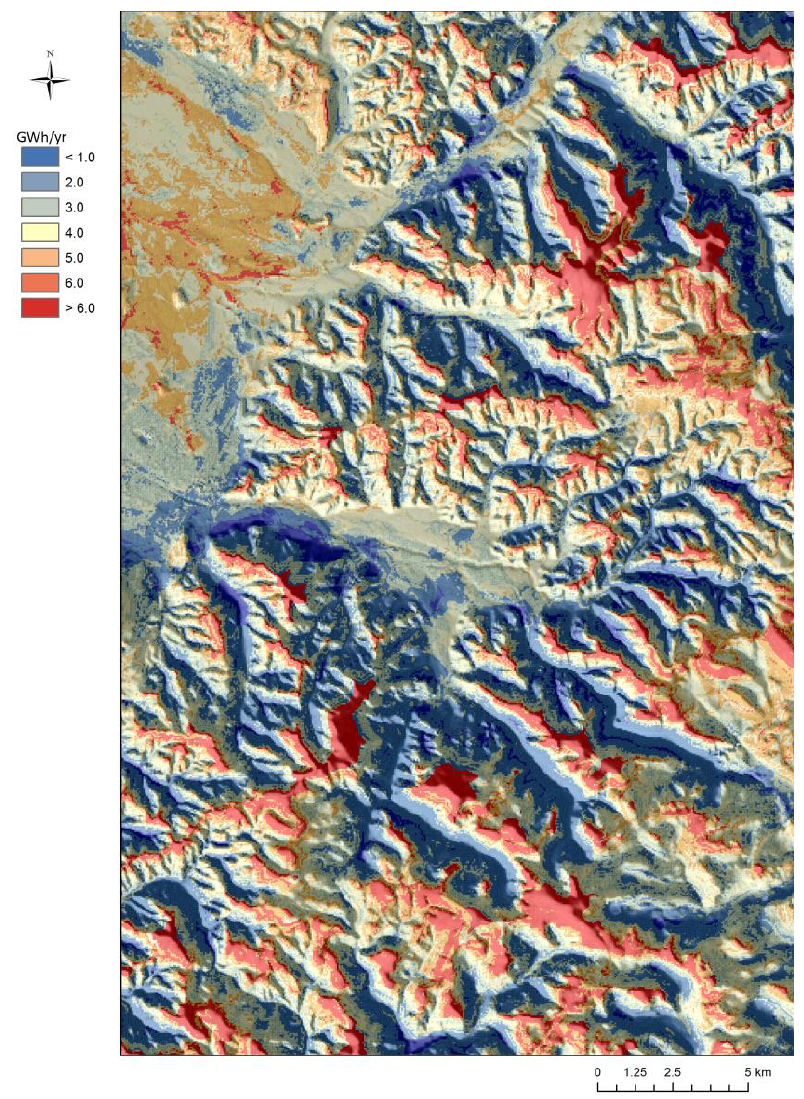
Figure 7. AEY mod in the Southern Black Forest region. The legend values indicate highest class values.